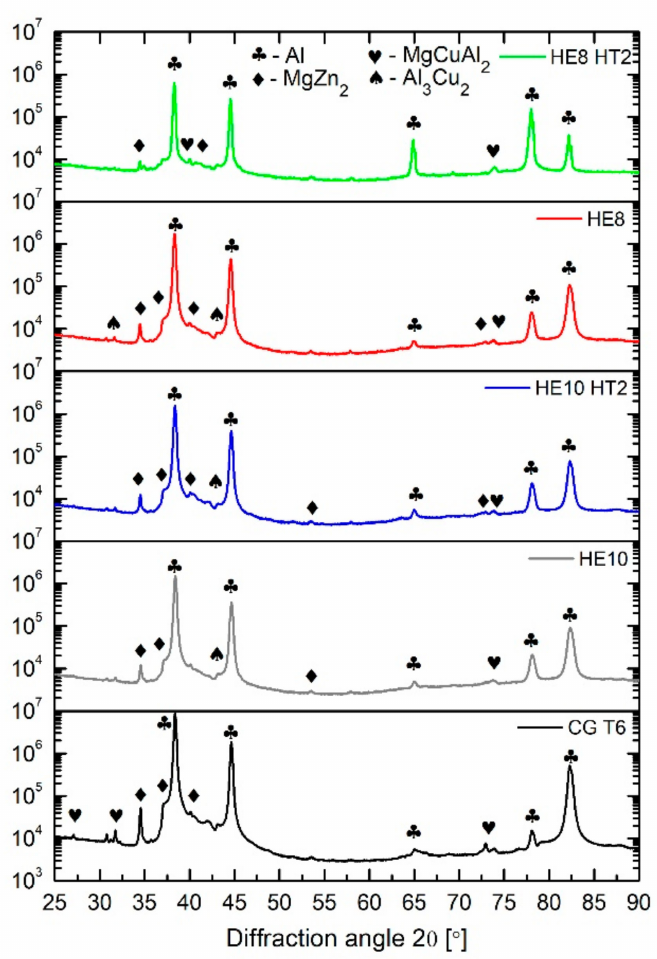
Figure 10. XRD analysis of the CG T6, HE10, HE10 HT2, HE8 and HE8 HT2 samples (PDF no. of the phases identified: PDF 00-004-0787—Al, PDF 01-073-5874—MgCuAl 2 , PDF 00-034-0457—MgZn 2 , PDF 01-071-5716—Al 3 Cu 2